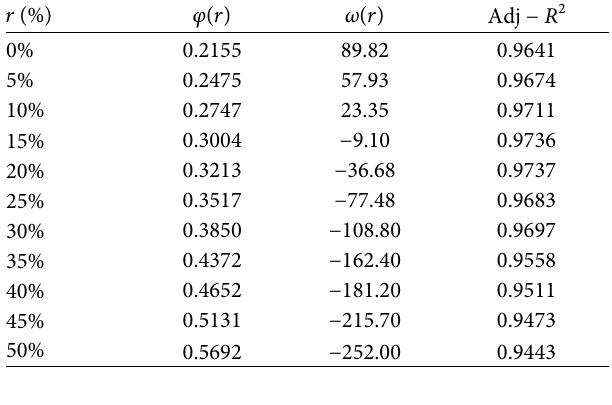
Table 3: The values of 𝜑(𝑟) and 𝜔(𝑟) .